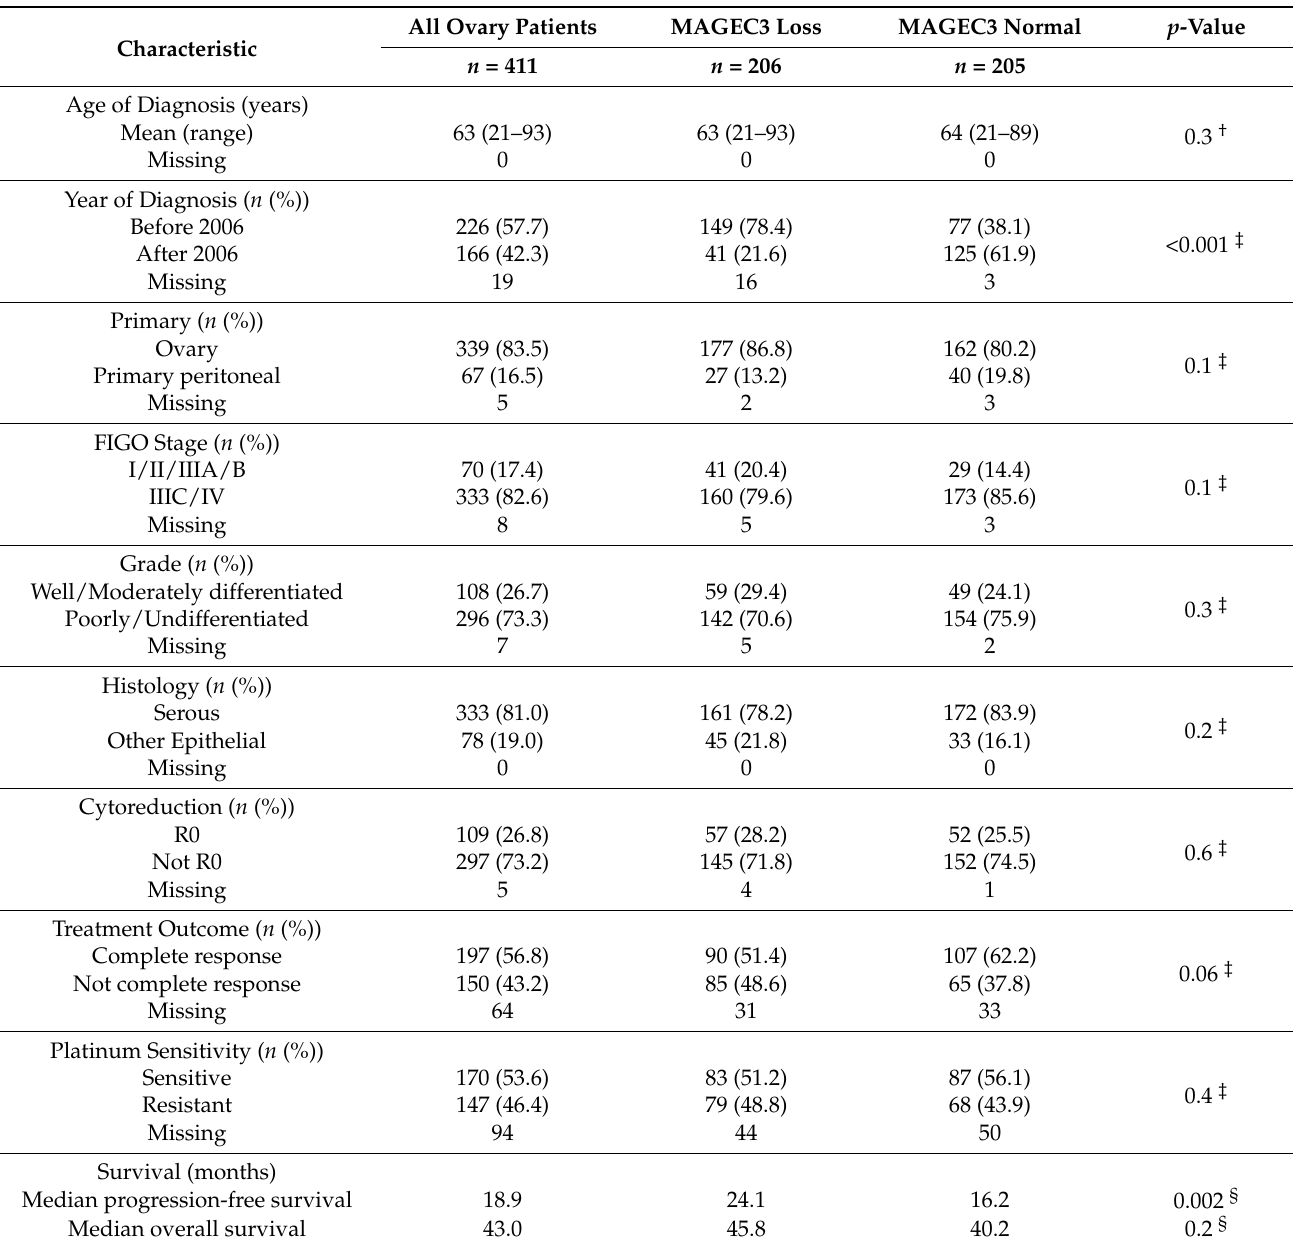
Table 1. Discovery cohort clinical characteristics. Clinical characteristics of the ovarian cancer discovery cohort by MAGEC3 protein